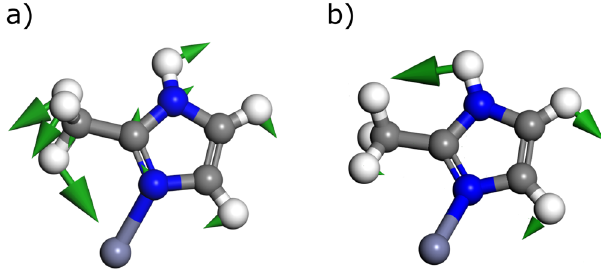
Fig. 4 Graphical representation of highlighted vibrational modes. Vibration modes at a 365 and b 1063 cm -1 as computed by DFT. For clarity only the singly bound 2-methylimidazolate linker that are vibrating are shown. Grey spheres represent carbon, blue represent nitrogen, white represent hydrogen and lilac represent zinc. Green arrows indicate the direction and intensity of the vibration motion for each atom.